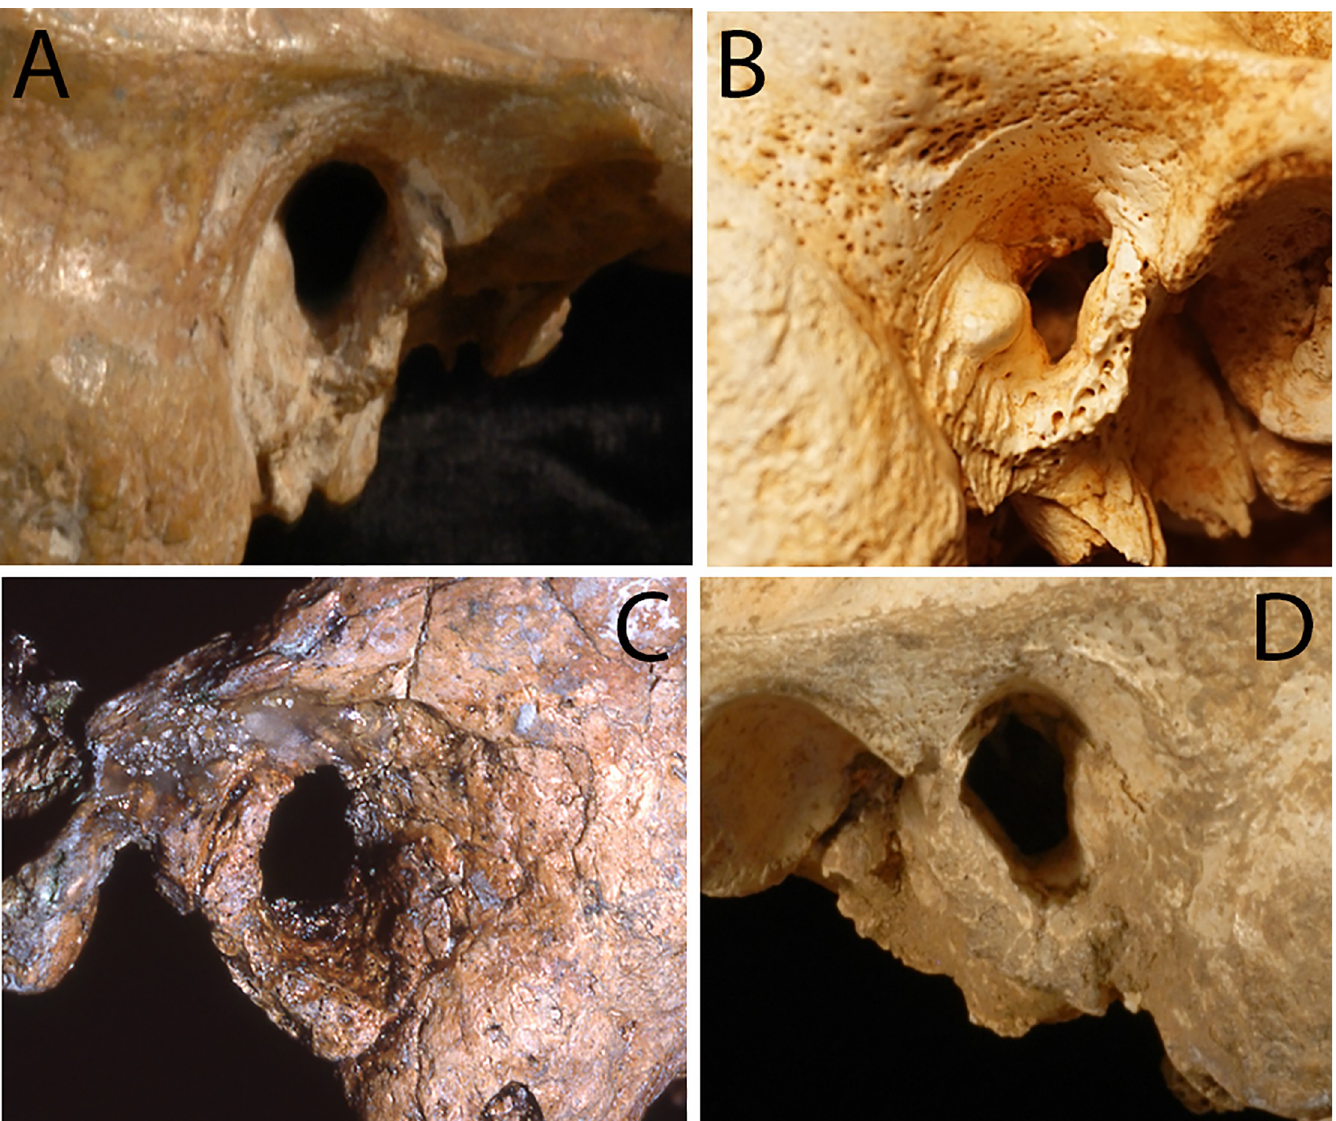
Fig 3. Examples of external auditory exostoses (EAE) among early modern human specimens. A: E/MUP Cioclovina 1 right (grade 1); B: LUP Iboussi è res A right (grade 2); C: MPMH Skhul 6 left (grade 1); D: E/MUP Oase 2 left (grade 1). Not to scale. Photos: A, C and D: E. Trinkaus; B: M. Samsel.